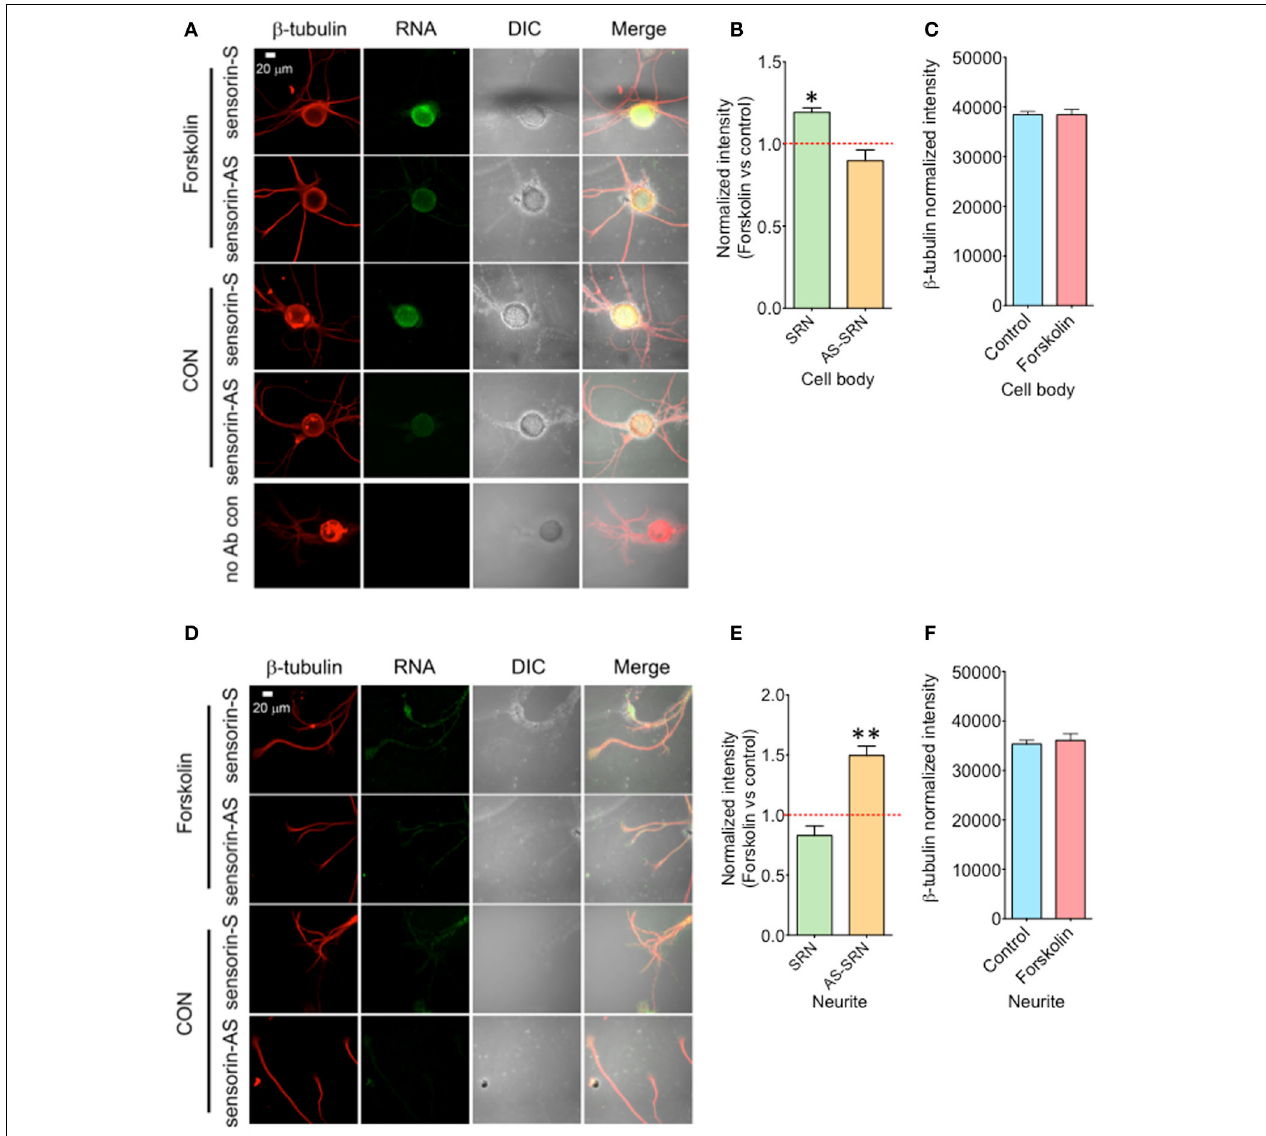
FIGURE 4 | Forskolin exposure enhances expression of NAT-SRN in Aplysia sensory neurons. Sensory neurons of mature Aplysia were cultured in vitro and were treated with forskolin (50 μ M, 30min) on DIV 4. (A) Confocal projection images of FISH analysis of sensorin RNA (SRN) (Green) and (D) that of AS-sensorin RNA (NAT-SRN) (Green) co-stained with β -tubulin protein (Red), as well as DIC images are shown. A no antibody control was used as non-specific hybridization control. Scale bar, 20 μ m. (B,E) show the